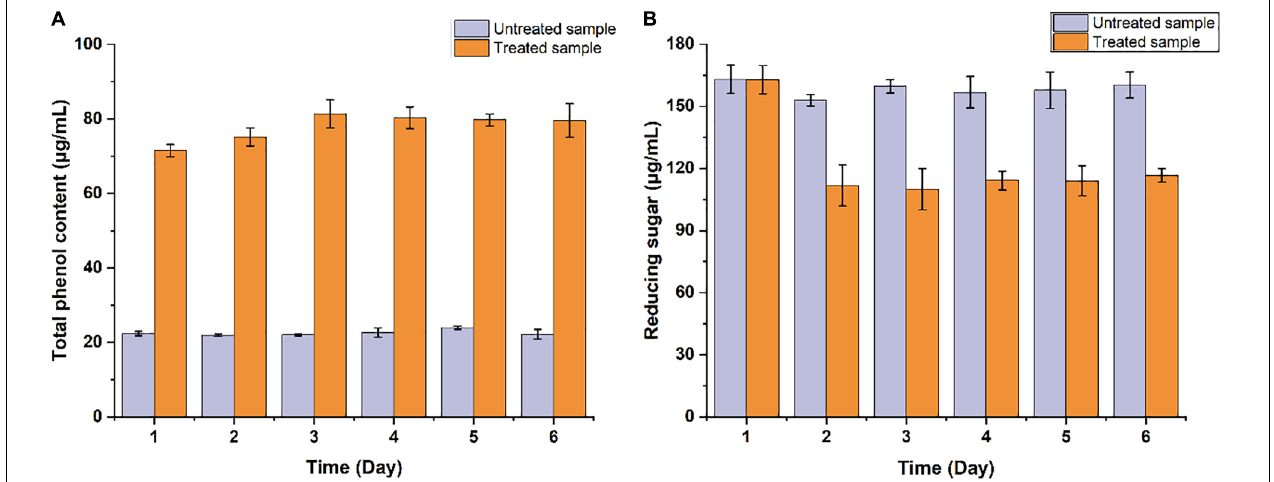
FIGURE 1 | Measurement of the concentration of (A) total phenol and (B) reducing sugar in the supernatant of Bacillus pumilus ZB1 treated and untreated basal medium containing masson pine.